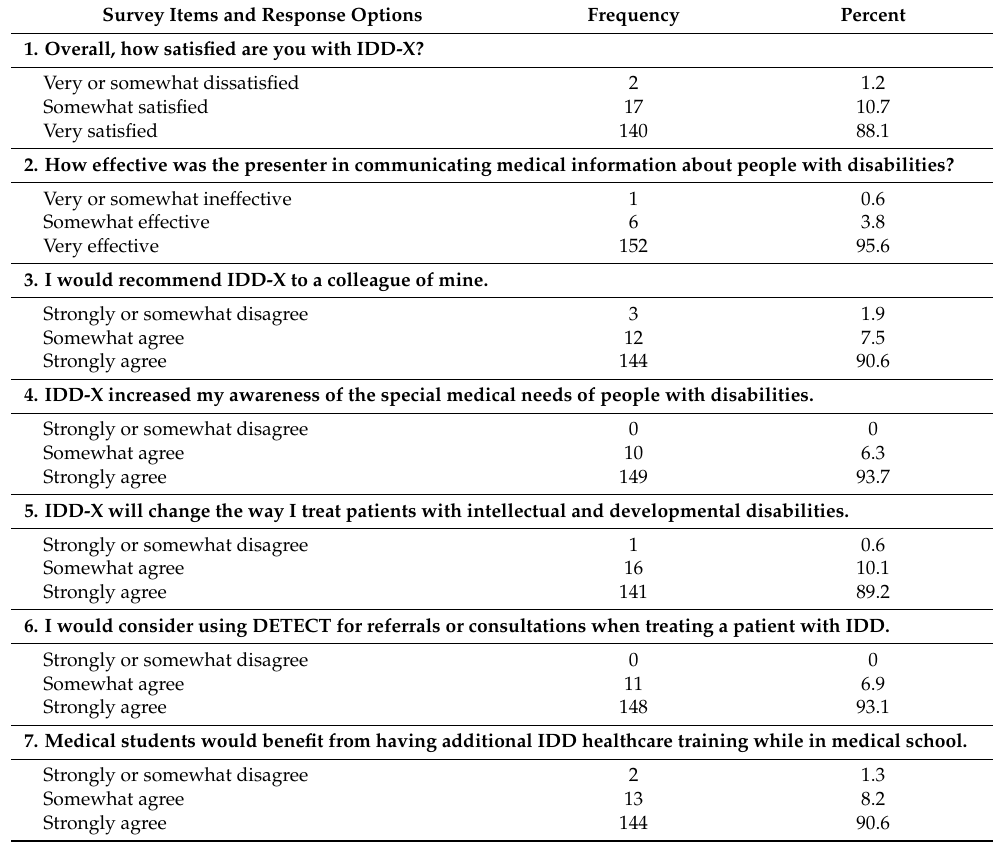
Table 5. Subjective Impact Ratings of DETECT’s IDD-X